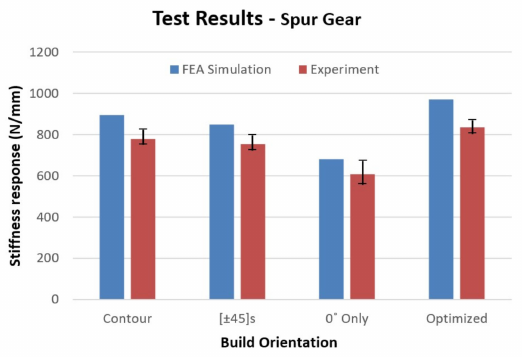
Figure 31. Comparison of results between FEA simulation and experimental